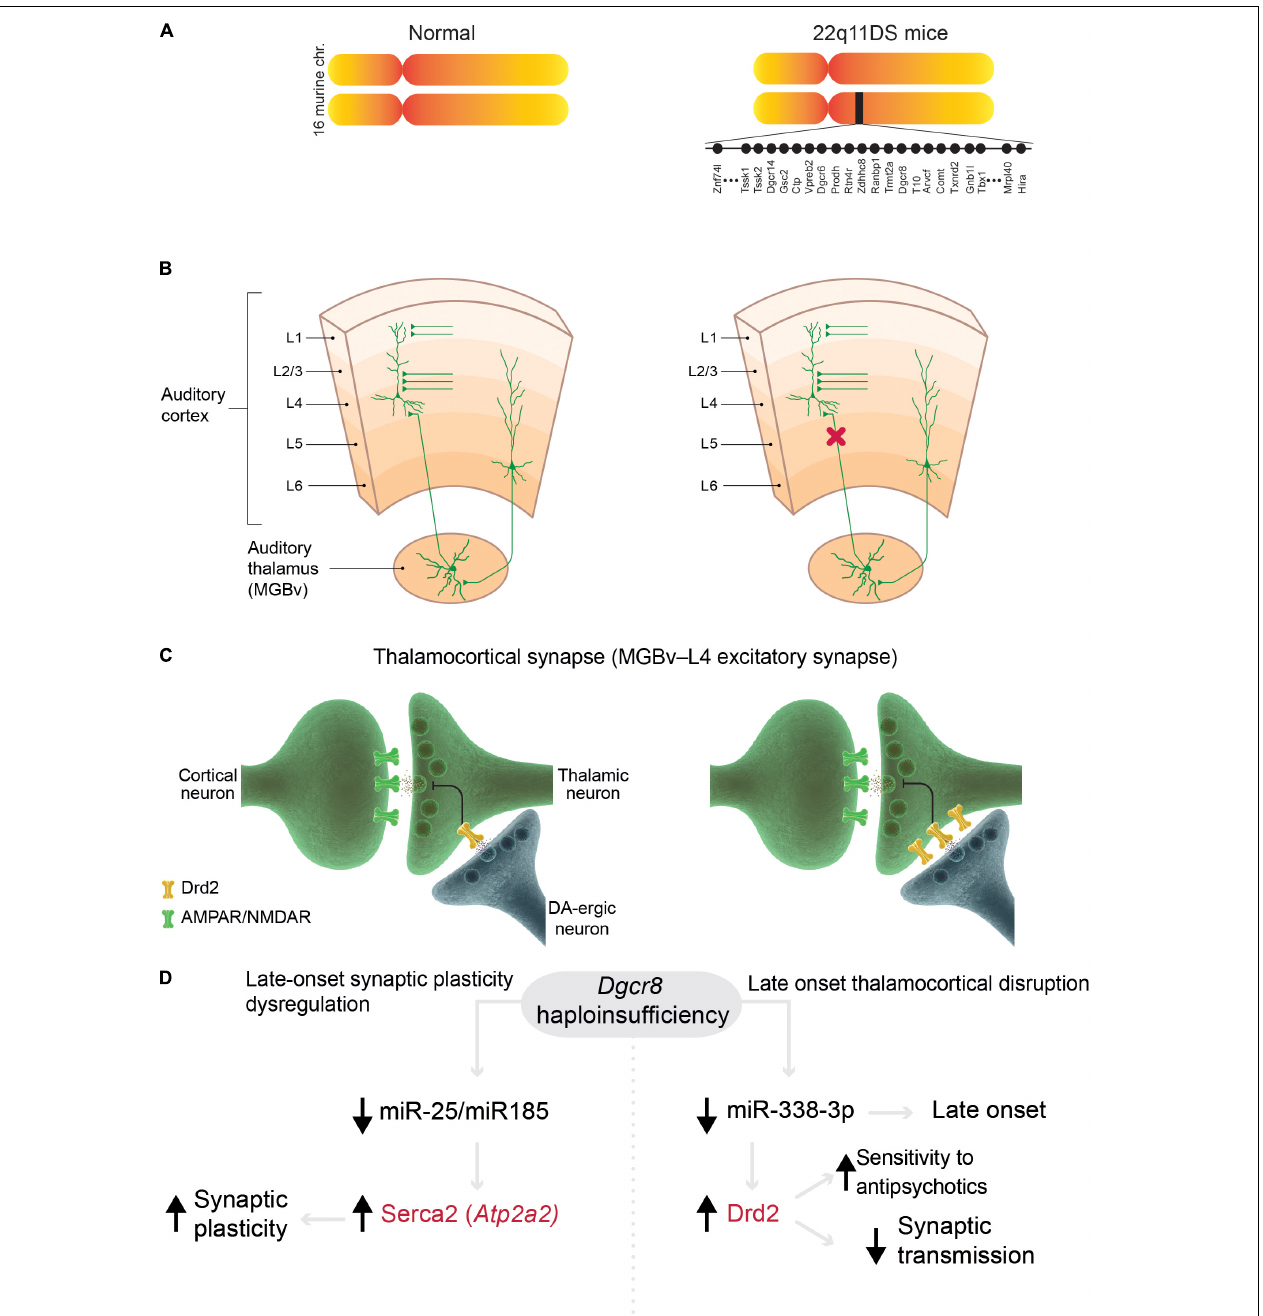
FIGURE 2 | Models of 22q11 deletion syndrome (22q11DS) reveal mechanisms in common with schizophrenia. (A) Mouse models of 22q11DS carry a hemizygous microdeletion of the genomic region of mouse chromosome 16 (MMU 16qA13) containing orthologs deleted in the syntenic 22q11.2 locus in humans. Each filled circle represents one gene. (B,C) Mechanisms of specific thalamocortical functional disruption in 22q11DS mice. (B) Synaptic transmission at excitatory thalamocortical projections between the auditory thalamus [medial geniculate body, ventral division (MGBv)] and the auditory cortex is reduced (decrease in probability of glutamate release from thalamic presynaptic terminals, red X) but other excitatory projections (corticocortical and corticothalamic projections) remain intact in 22q11DS mice. (C) The deficit in synaptic transmission in 22q11DS mice is caused by reduced glutamate release from thalamic presynaptic terminals due to upregulation of Drd2 in the thalamic neurons (Chun et al., 2014). DA-ergic neuron, dopaminergic neuron. (D) In 22q11DS mice, late-onset deficits in synaptic plasticity (left) and thalamocortical synaptic transmission (right) are caused by Dgcr8 haploinsufficiency and miRNA depletion. Abnormal synaptic plasticity depends on age-dependent dysregulation of Serca2 in 22q11DS, which was originally described in hippocampal synapses (Earls et al., 2010, 2012). This mechanism presumably affects most excitatory synapses in the brain. This age-dependent mechanism was described in auditory thalamocortical synapses (Chun et al., 2017). Mutations in ATP2A2 (encoding SERCA2) and DRD2 (in red) were identified as common risk variants in schizophrenia (Ripke et al., 2014).